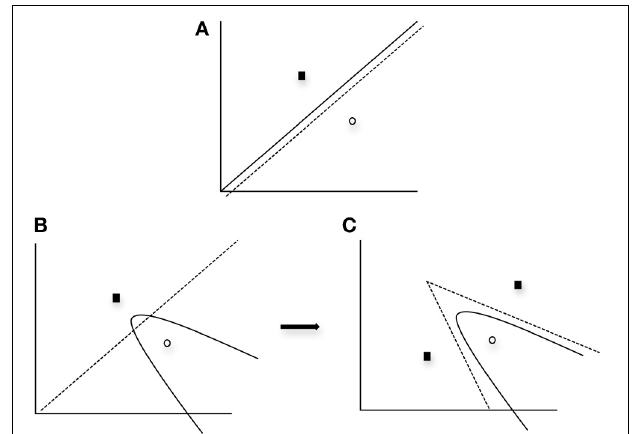
FIGURE 3 | Graphical example of the SPC modeling approach when (A) one unit per category is applied to a linear condition, (B) one unit per category is applied to a nonlinear condition, and (C) two units for one category and one unit for the other category is applied to a nonlinear condition. Solid line and curves represent the “optimal” rule, whereas the dashed line and curves represent the partition between categories provided by the units. Note with the use of additional units for the nonlinear condition (panel C ), the optimal quadratic bound (represented as the solid curve) is approximated by piecewise linear bounds. In all cases, black squares represent Category A units and open circles represent Category B